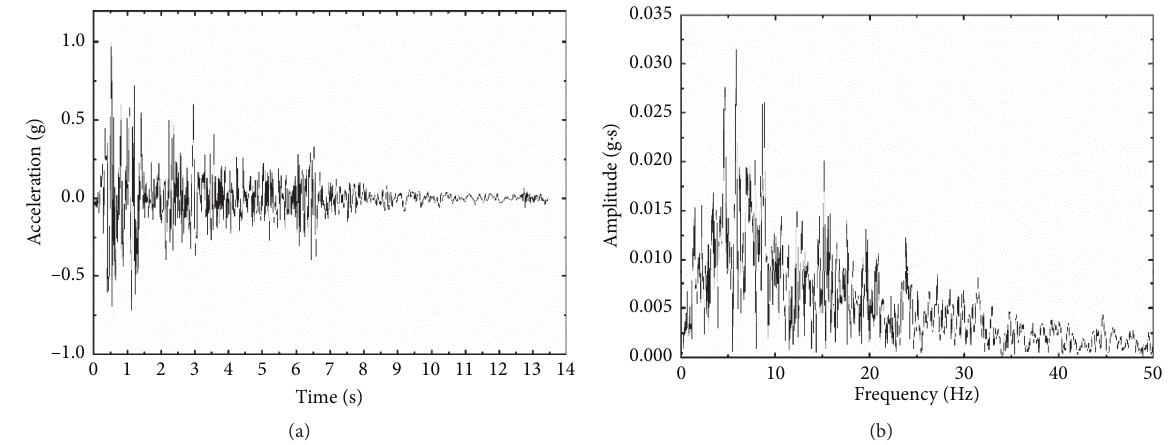
Figure 5: Input El-Centro wave. (a) Time history of acceleration. (b) Fourier spectrum.